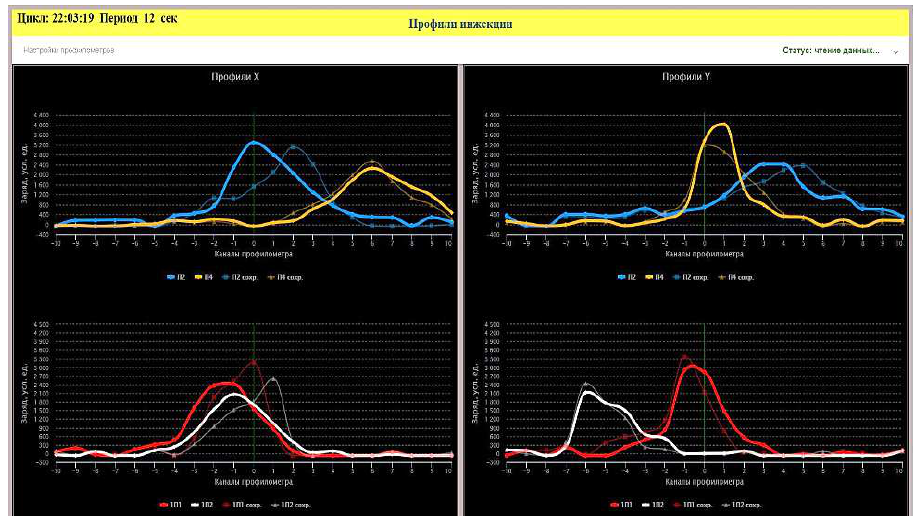
Figure 4. The client Web-page